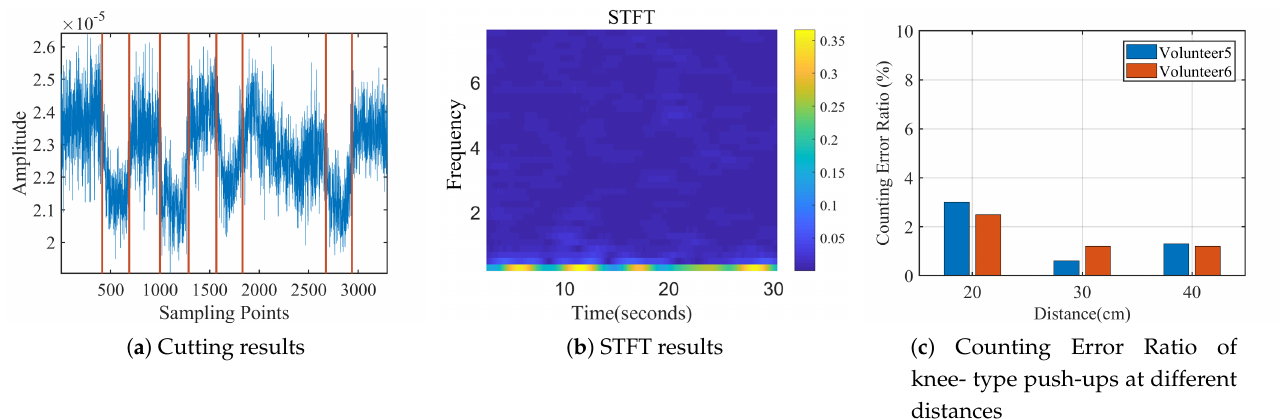
Figure 17. Experiment about knee-type push-ups conducted by